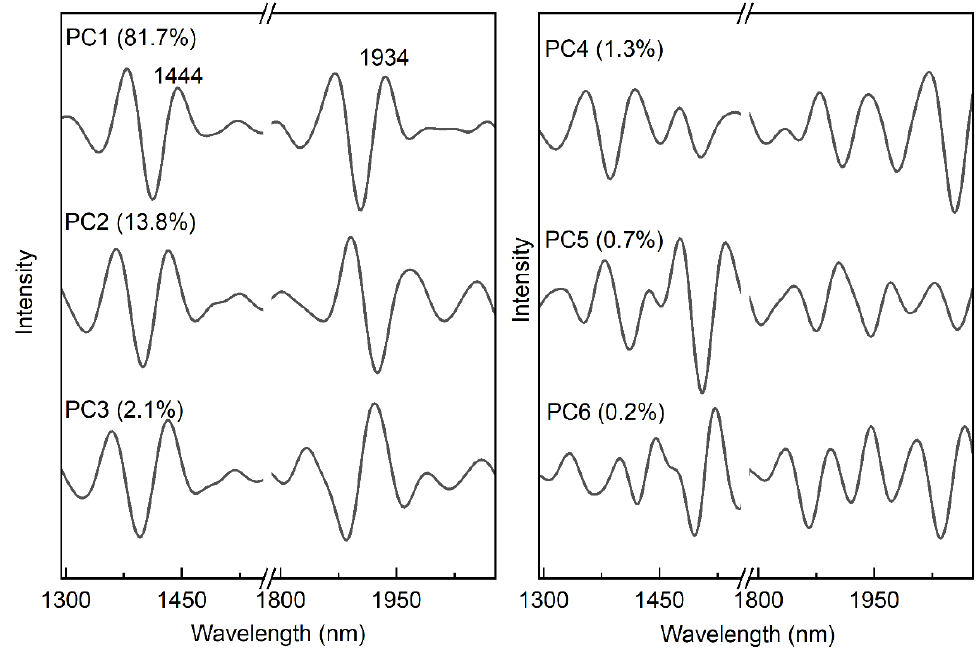
Figure 3. The first through the sixth loadings in the PCA model, after the mutual parts have been removed.